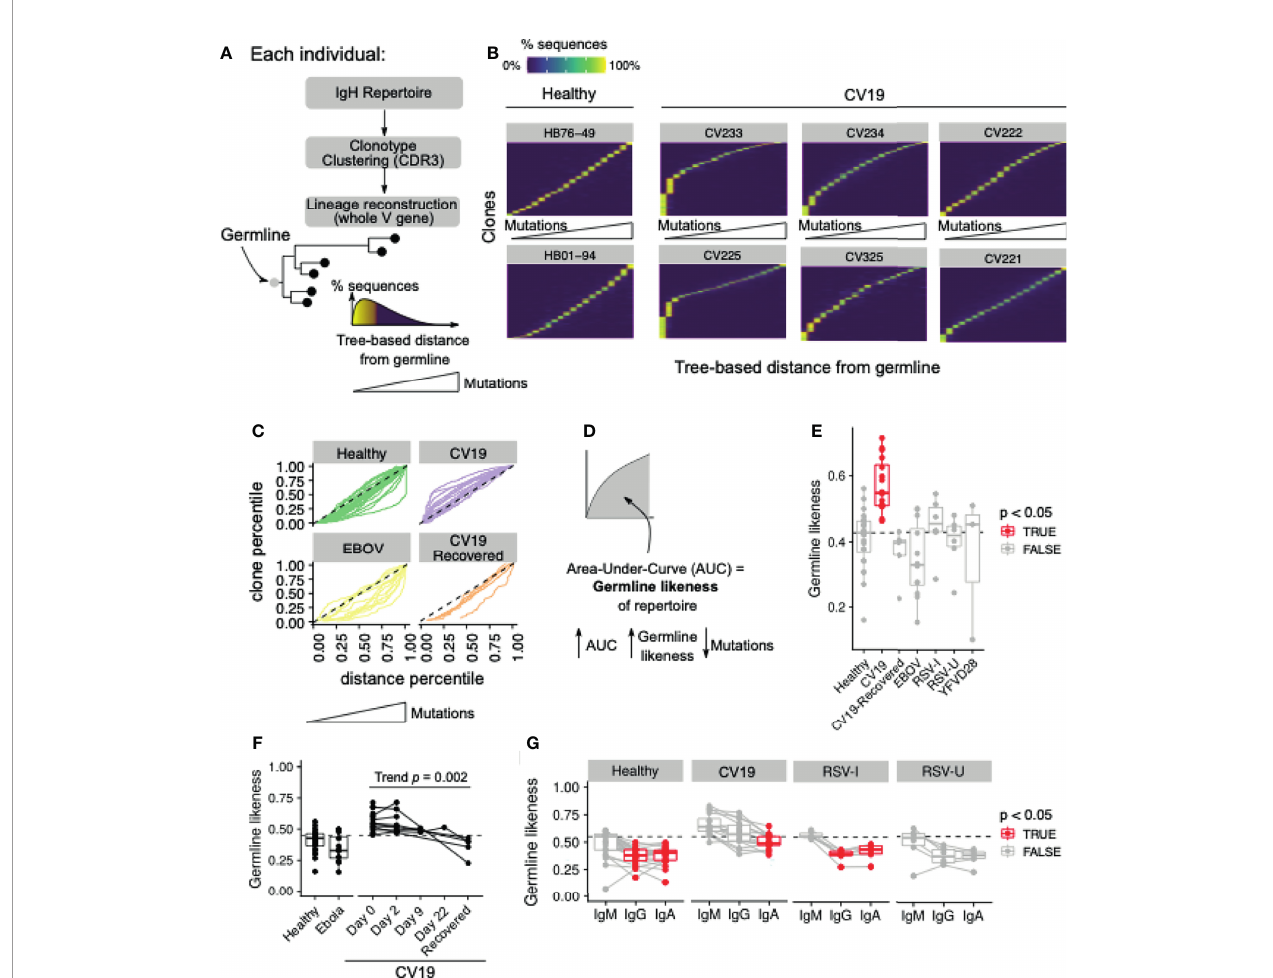
FIGURE 5 | Mutational levels in BCR lineages indicate lower somatic hypermutation in CV19. (A) Lineage trees were constructed by clonotyping the IgH CDR3 and the lineages reconstructed using the whole V gene rooting on the predicted germline, allowing the distance from germline to be estimated for each sequence. This allows ordering of sequences based on this distance from germline: depicted as a histogram [ (A) bottom right]. (B) Clones in the repertoire, for selected donors, were ordered (vertical axis) using median distance from germline (horizontal axis), and the distribution of such distance for each clone was plotted with heatmap colours being the percentage of sequences within the clone containing the a given level of mutation. (C) Distance from germline distributions for every donor, split by condition, represented as curves. Dotted line represents the theoretical expectation of mutational level. (D) From each of these curves (in c ) the area under the curve (AUC) was calculated giving a statistic of ‘ Germline Likeness ’ , a higher AUC resembling more the germline and a lower AUC indicating more mutations. (E) Comparison of Germline Likeness between conditions: sample types with signi fi cant (Benjamini-Hochberg-corrected false discovery rate [FDR] < 0.05) differences compared to Healthy (Wilcoxon rank-sum test) are highlighted in red with the dotted line being the healthy median. (F) The Germline Likeness across timepoints for CV19 patients with Healthy and Ebola data are reproduced here for comparison: trend was evaluated using the Jonckheere-Terpstra test. (G) Comparison of germline distance split by immunoglobulin isotype was performed split by cohort: signi fi cant (FDR < 0.05) differences compared to IgM (Wilcoxon rank-sum test) are highlighted in